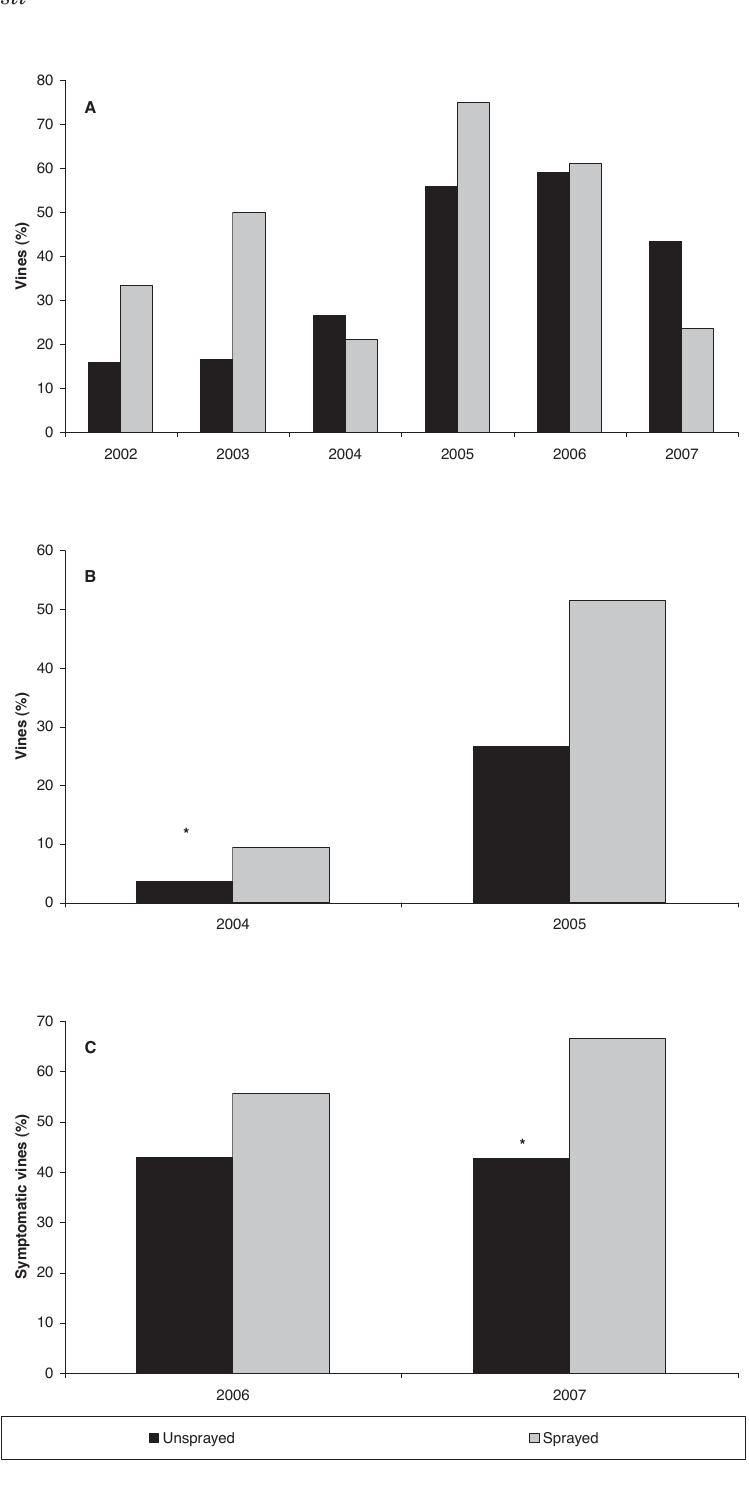
Fig. 4. Effects of sprays of Brotomax (A), Fitostim (B) and Marvita (C) on the incidence of symptomatic vines that had shown symptoms in previous years calculated in 3 different vineyards cv. Pignoletto. For each biostimulant sprayed and each year, bars marked with an ‘S’ differ signi fi cantly according to the Chi-Square test ( P